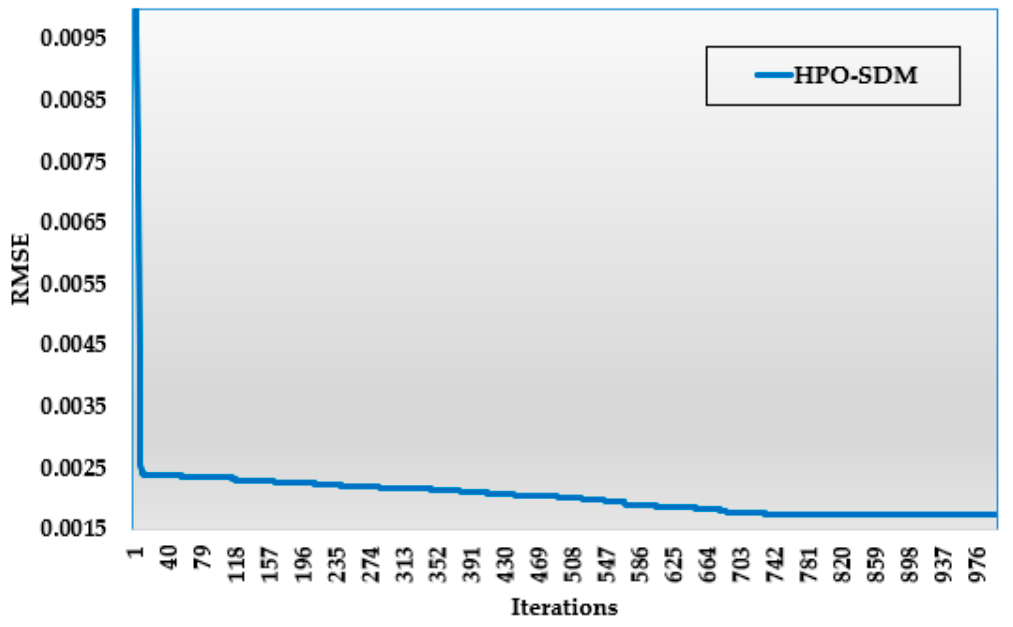
Figure 5. Convergence trend of the proposed HPO technique for the single-diode model of STM6_40/36 PV module.